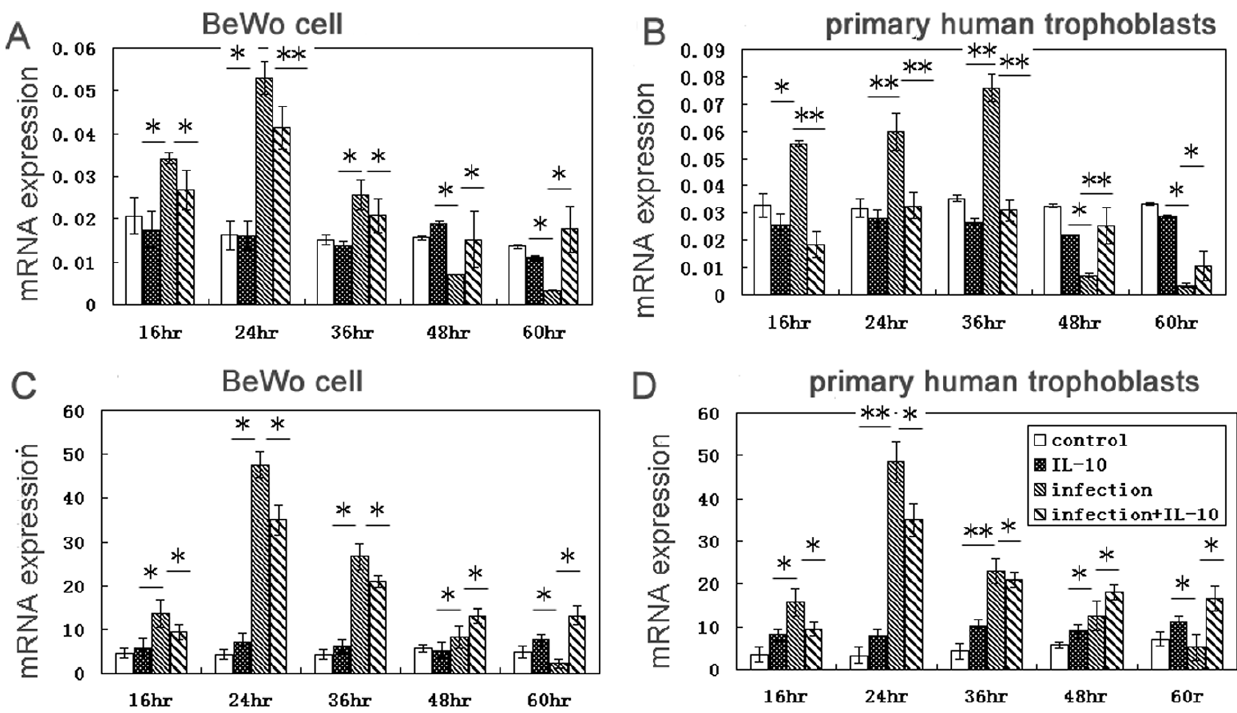
Figure 2. HLA-G expression in infected cells decreased by IL-10 treatment. HLA-G mRNA expression was analyzed in infected and uninfected BeWo cells (A) and primary human trophoblast cells (B) with and without IL-10 treatment. (C) HLA-G protein expression was analyzed in infected and uninfected BeWo cells with and without IL-10 treatment. (D) HLA-G protein expression was analyzed in infected and uninfected trophoblasts with and without IL-10 treatment. * p , 0.05; ** p , 0.01.